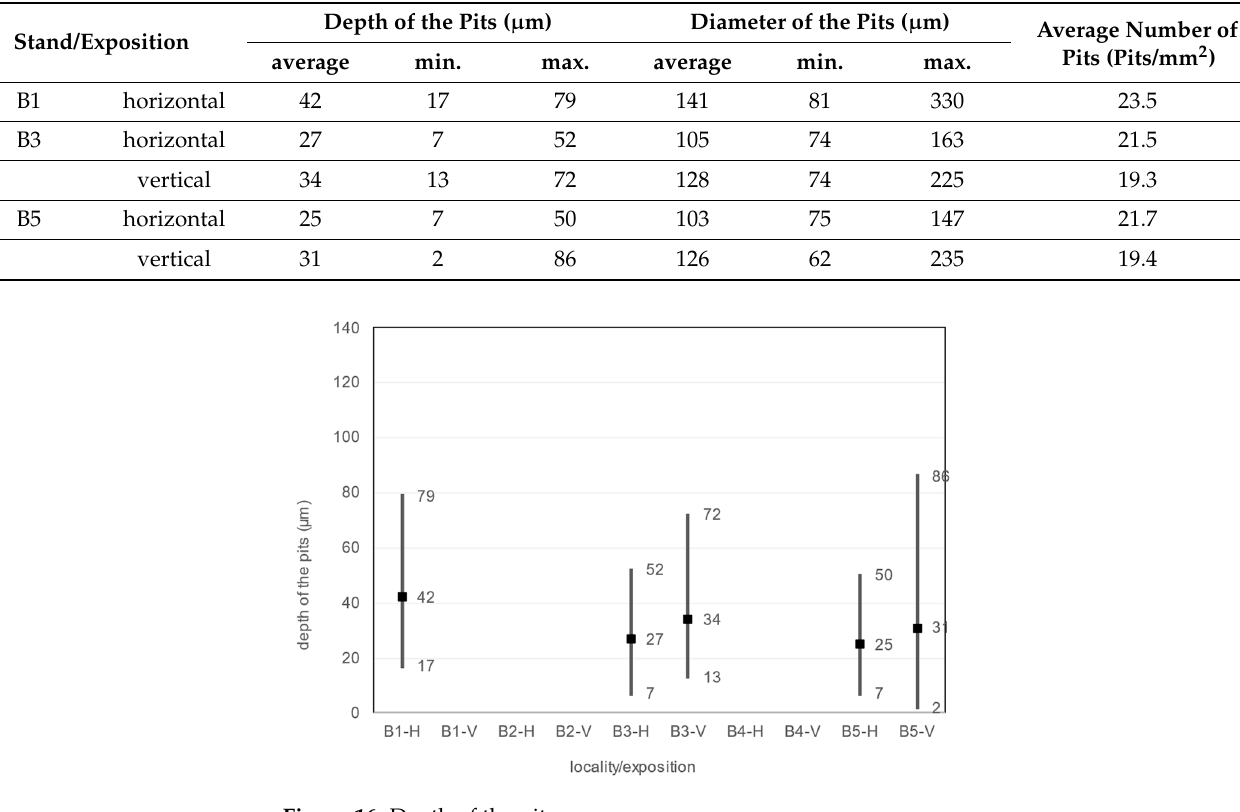
Figure 17. Diameter of the pits.